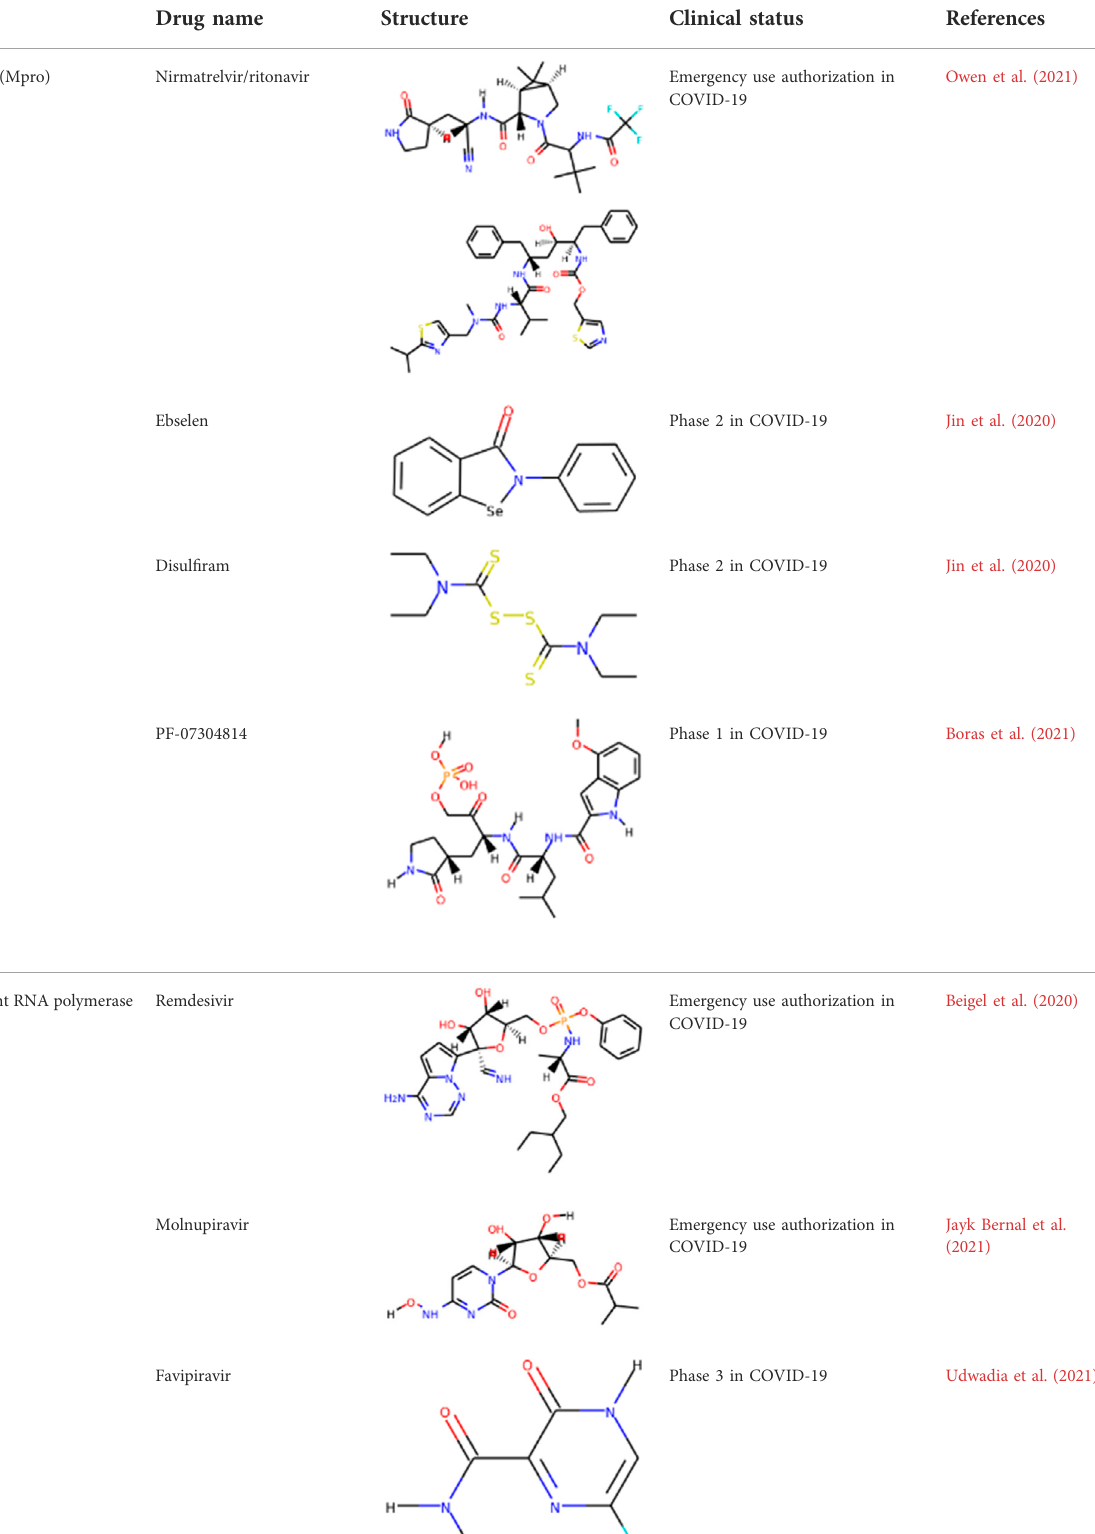
TABLE 1 Protease enzyme and RdRP inhibitors at or after clinical